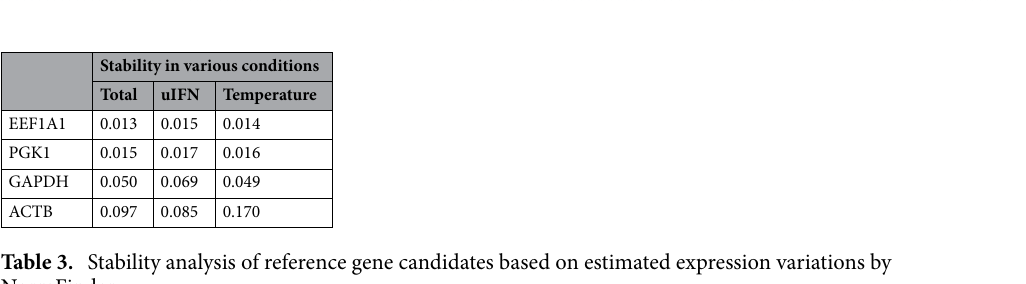
Table 2. Stability analysis of reference gene candidates based on pairwise correlations by BestKeeper.